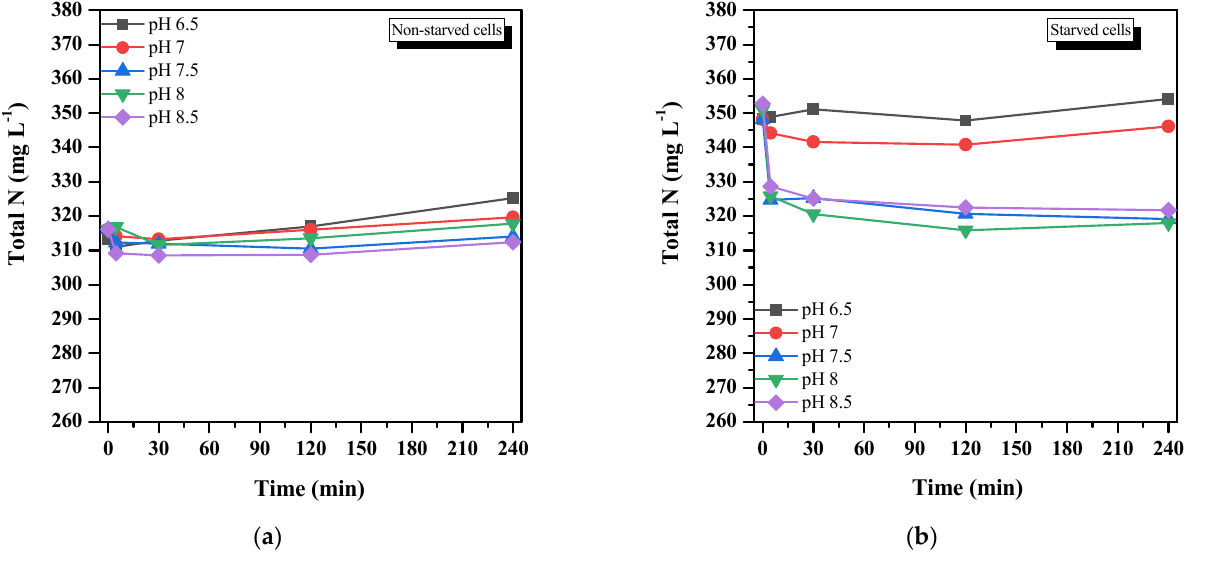
Figure 6. Impact of medium pH on variation in Total Nitrogen concentration (mg L − 1 ) in non-starved ( a ) and 3-day-starved cells ( b ) of nitrifying cultures. Incubation conditions included temperature of 25 ◦ C, fresh NH 4 + -N addition of 250 mg N L − 1 , and cell density of 500 mg TSS L − 1 , equivalent to 1.29 × 10 9 cells mL − 1